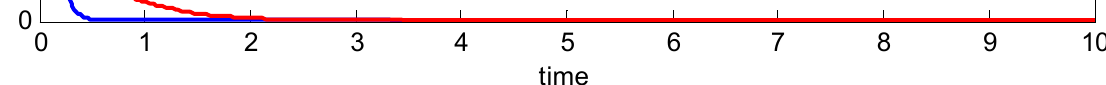
Figure 3. Comparing the vaccinated and non-vaccinated susceptible populations.